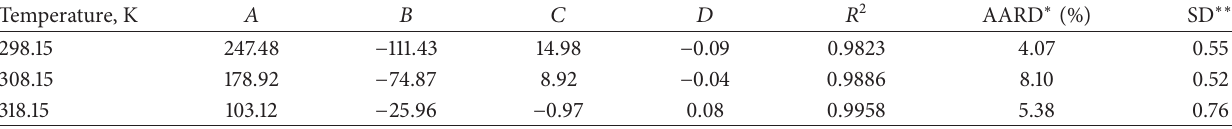
Table 2: Binodal curve coefficients of (1) for PEG 6000 + sodium succinate + water at various temperatures. Temperature, K